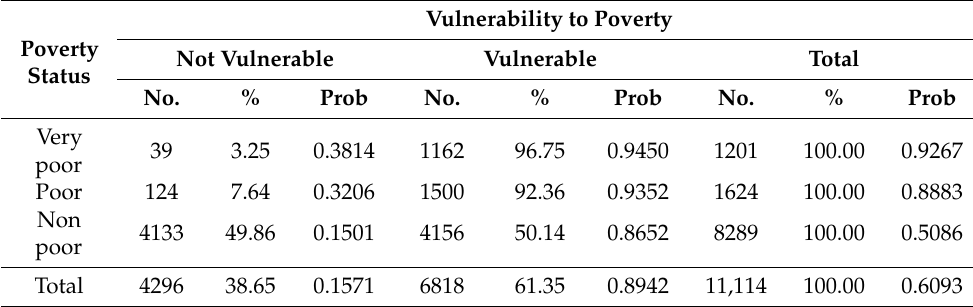
Table 4. Vulnerability with Social Expenditure,